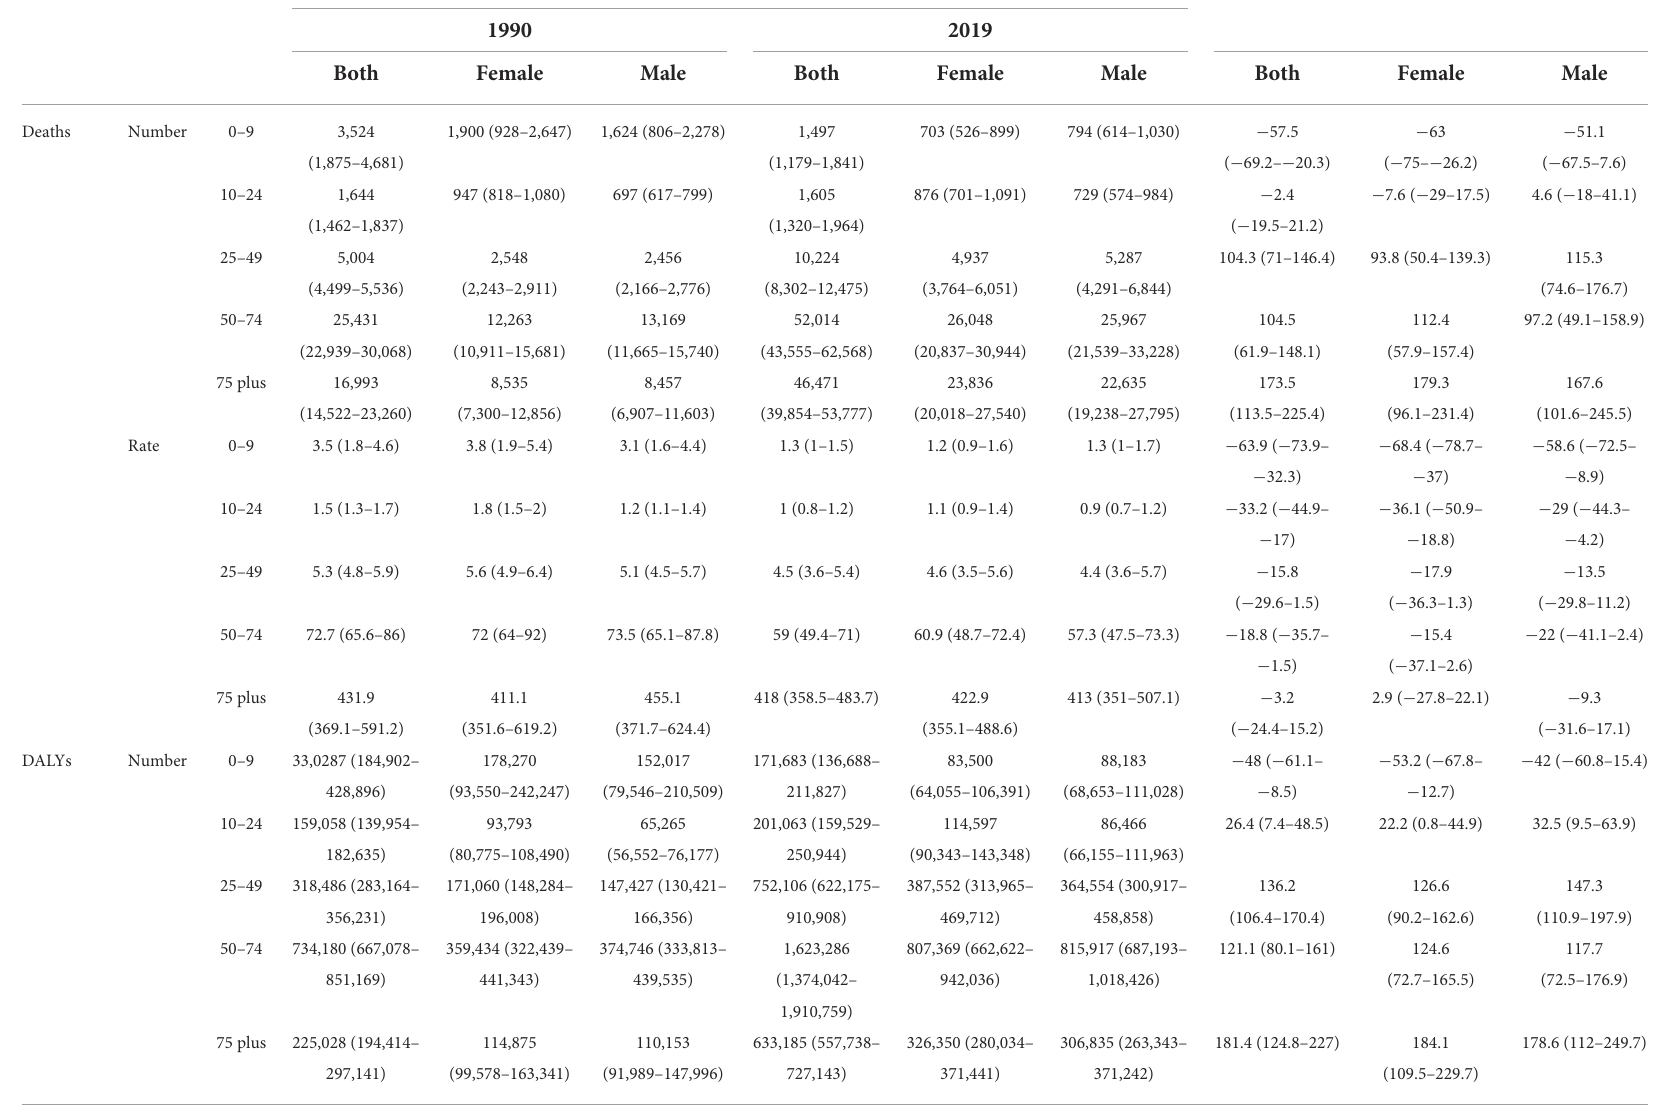
TABLE 2 Health measures of CKD based on age groups and sex during 1990-2019 in NAME region.